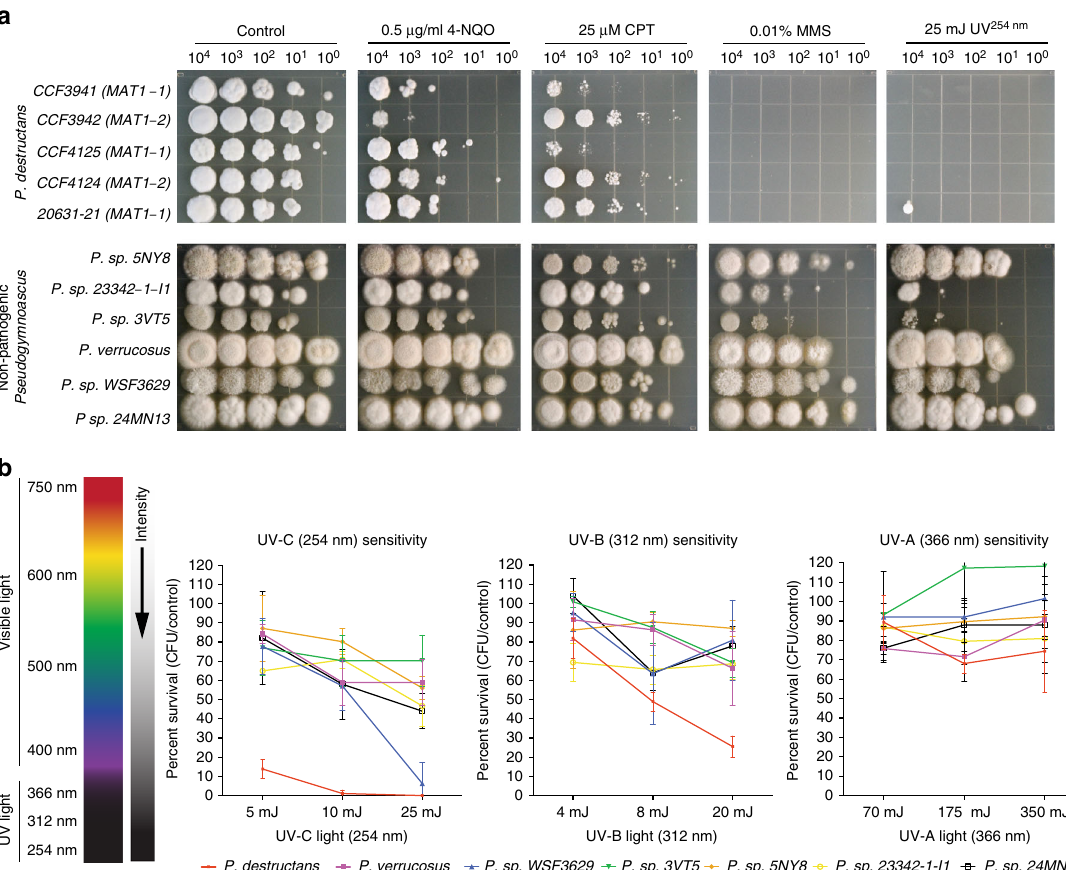
Fig. 4 Sensitivity of Pseudogymnoascus species to DNA-damaging agents. a Qualitative plate assay measuring the effects of four DNA-damaging agents on the growth of each fungal species (4-nitroquinoline (4-NQO), camptothecin (CPT), methyl methanesulfonate (MMS), and 254-nm ultraviolet light (UV- C)). Fungal spores were serially diluted, inoculated on appropriate medium, and growth was quanti fi ed after 7-day incubation at 15 °C. Multiple isolates of P. destructans were tested alongside the nonpathogenic Pseudogymnoascus species. b A quantitative assay using colony-forming units (CFUs) to measure survival of each fungus under different wavelengths of UV light (254 nm (UV-C), 312 nm (UV-B), and 366 nm (UV-A)). CFU assays were conducted in biological triplicate ( n = 3) and error bars represent standard